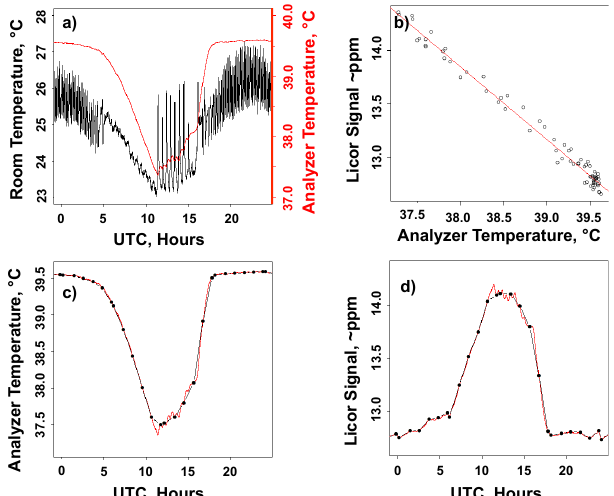
Fig. C2. Poor temperature control performance for the CO 2 an- alyzer at WGC on 7 August 2010. (a) Room temperature (black curve, left axis) and Li-cor cell temperature (red curve, right axis). (b) Li-cor CO2C2 (baseline) signal versus analyzer temperature. (c) Li-cor cell temperature (red curve) and the same temperature sig- nal sampled corresponding to CO2C2 measurements (black filled circles) and interpolated to all times (black connecting lines). (d) CO2C2 measurements (black filled circles) interpolated linearly in time (black connecting lines) and estimated for all times using the slope from (b) multiplied by the difference between the black and red lines in (c)